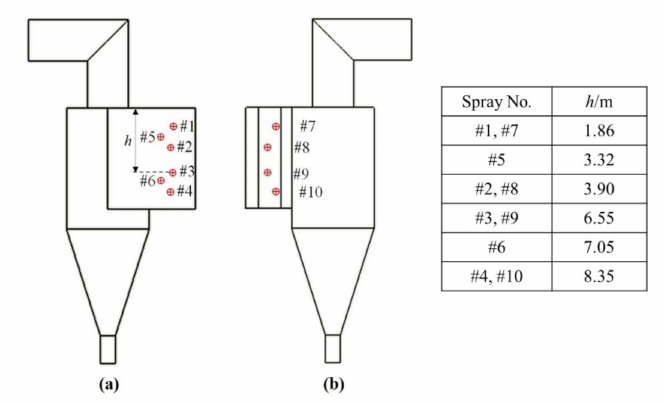
Figure 4. Detailed positions of the urea pray guns/horizontal measurement ports at SNCR inlets: ( a ) view from the straight edge; and ( b ) view from the inclined